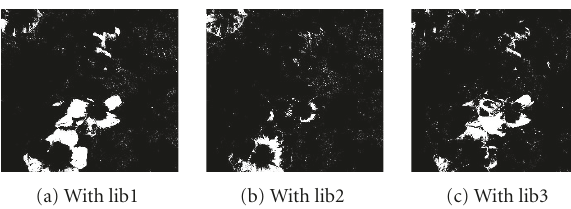
Figure 11: Result of detected image when maximum separation bands are used in the detection. Bands used are (4, 12, 20,